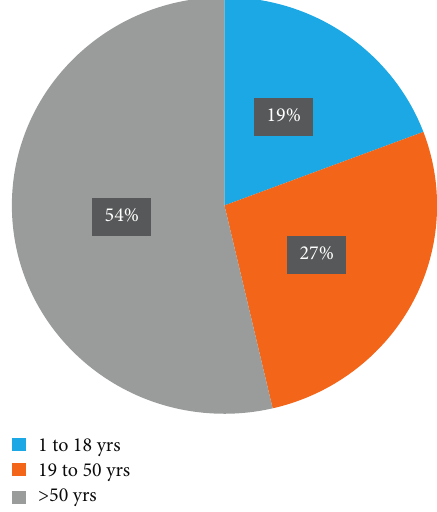
Figure 1: Age-wise distribution of the cancer patients with documented bacterial infections.